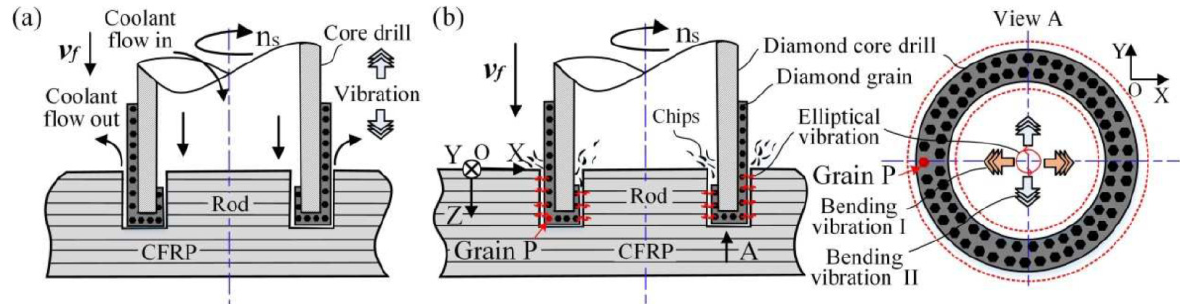
Figure 11. Illustrations of ( a ) RUM process and ( b ) RUEM processes (Reprinted with permission from Ref. [134], 2017, copyright Elsevier Ltd.).